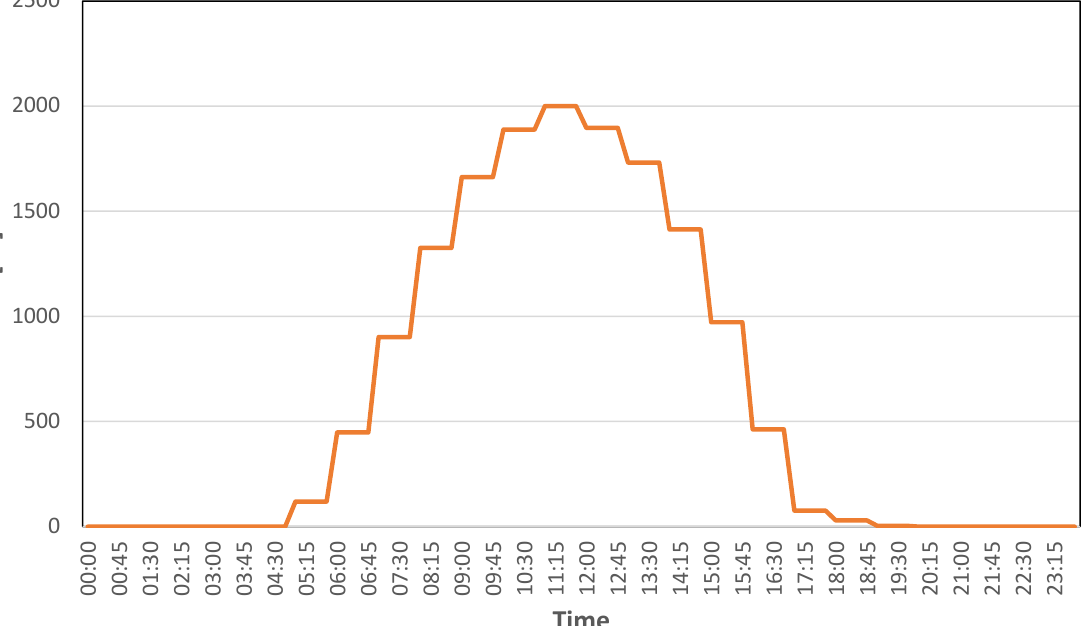
Figure 13. Forecasted PV production profile. Table 3. Battery Storage Characteristics [31].